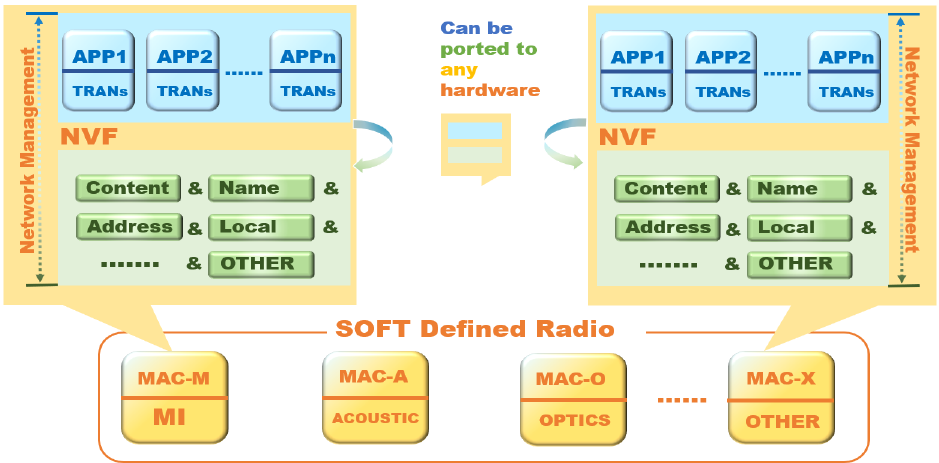
Figure 1. The architecture of MMNET (multimodal network). MMNET uses software defined radio (SDR) technology and standard hardware interface to realize multi-mode communication, including multimedia access (MAC) layer and physical layer, and uses network function virtualization (NFV) technology to organize application (APPs) layer, transmission layer (Trans) and routing layer.